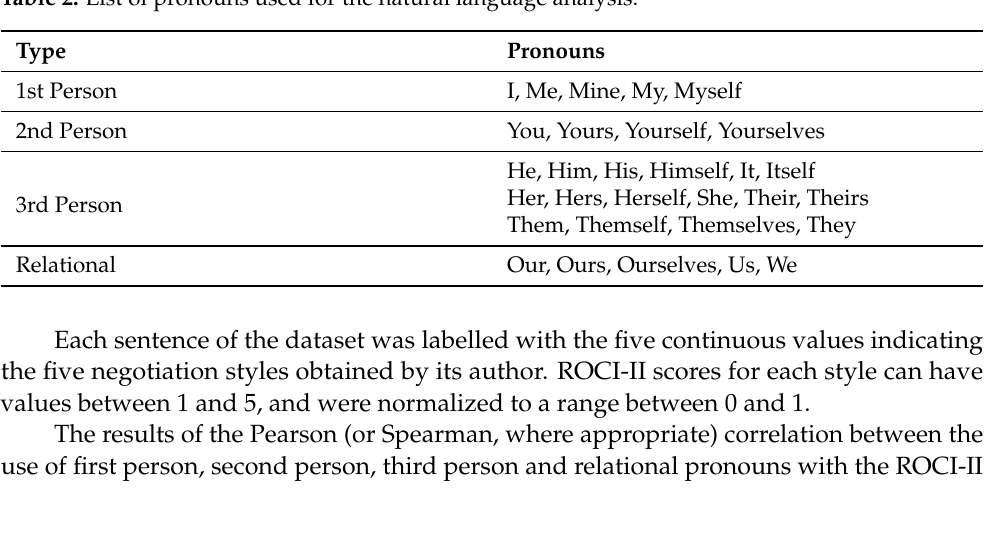
List of Stopwords